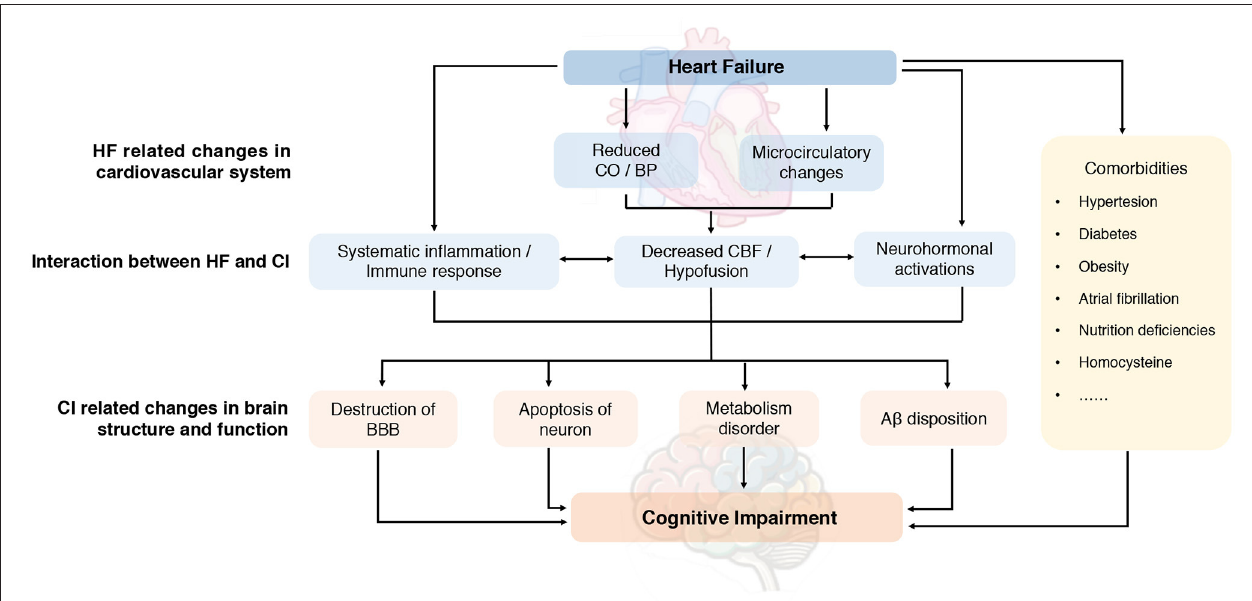
FIGURE 3 | Proposed pathophysiology of cognitive impairment in heart failure. A β , amyloid- β ; BBB, blood-brain barrier; BP, blood pressure; CBF, cerebral blood flow; CI, cognitive impairment; CO, cardiac output; HF, heart